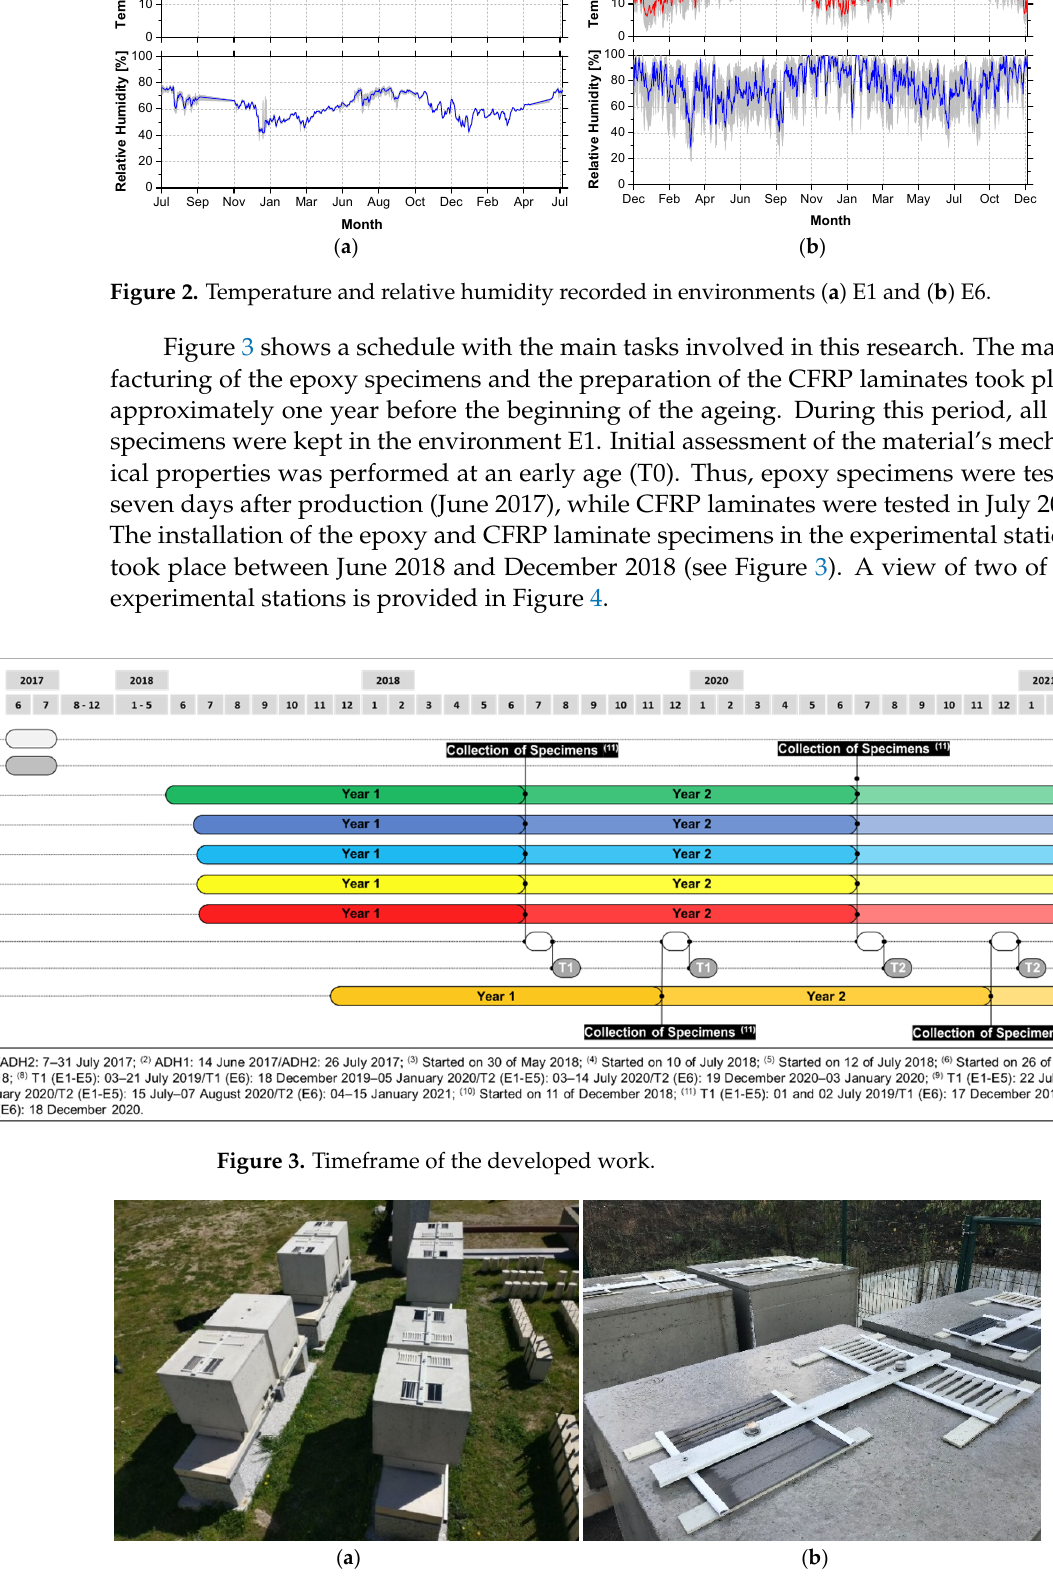
6 of 25 Figure 1. Flowchart of the FRPLongDur Project. Table 2. Environments considered in the present study. Environment Location Description E1